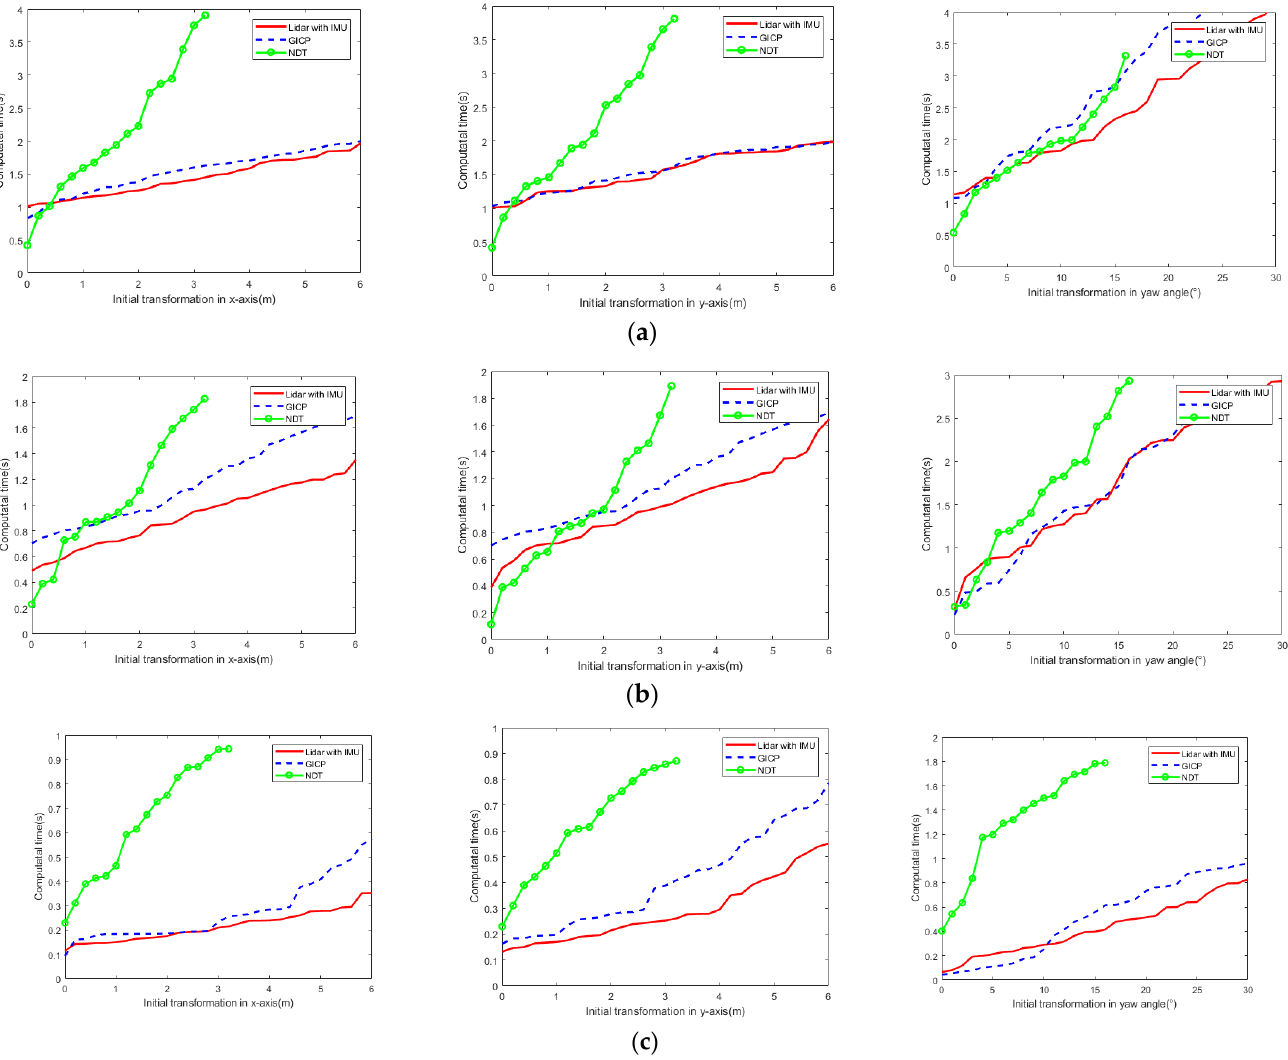
Figure 11. Calculation time of successful matching of different algorithms; ( left ) initial transformation in x-axis direction, ( middle ) y-axis direction, ( right ) initial yaw angle. ( a ) KITTI datasets; ( b ) Park datasets; ( c ) Coal mine roadway datasets.